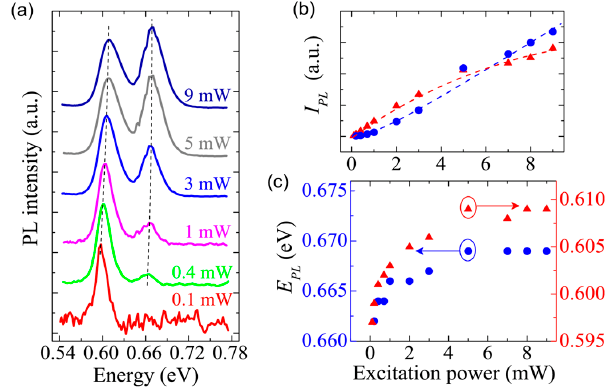
Figure 3. ( a ) Power dependent photoluminescence spectra of Mg-doped InN nanowires measured at 7 K. ( b , c ) Extracted integrated intensity and peak energy for two peaks as shown in ( a ). Red triangles are for the low-energy peak, and blue circles are for the high-energy peak. Dash lines are guide-for- eye [71].